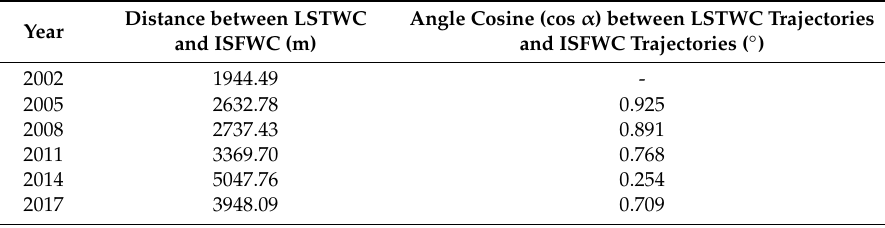
Table 9. The statistics of the coupling of LSTWCs and ISFWCs at the city scale. Angle Cosine (cos α ) between LSTWC Trajectories and